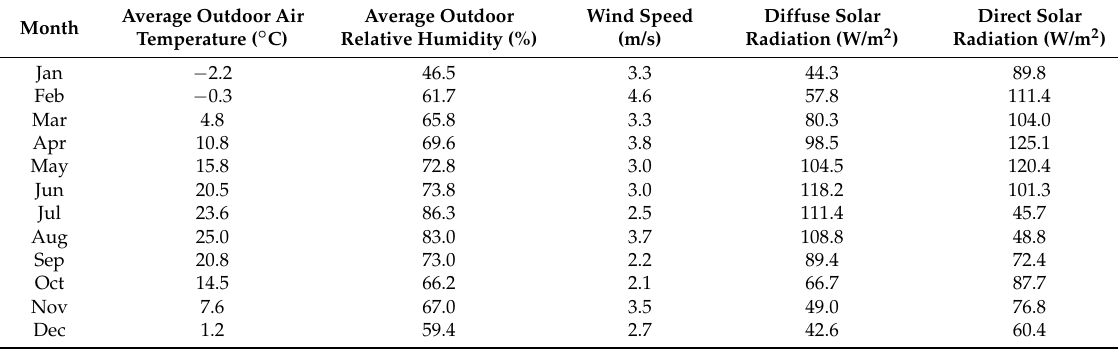
Table 5. Monthly weather data in Inchon, Korea.